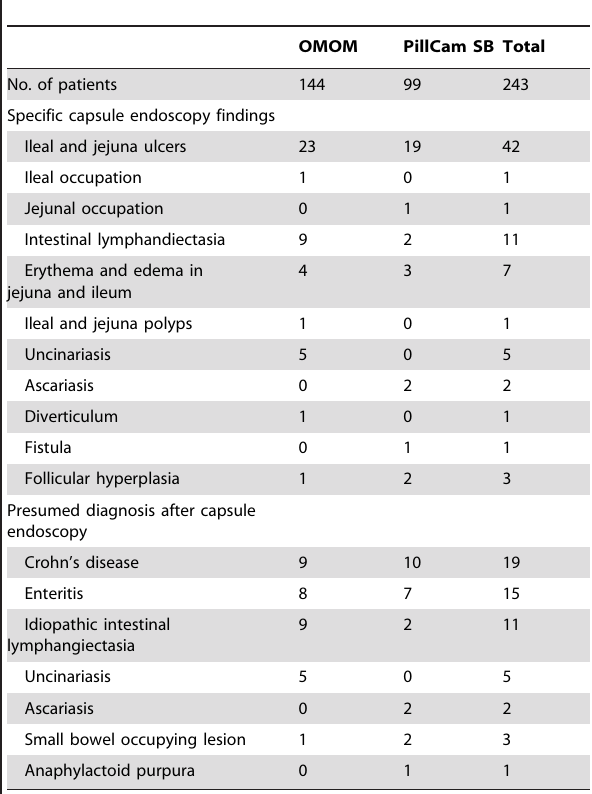
Table 2. CE findings in 243 patients with chronic abdominal pain.